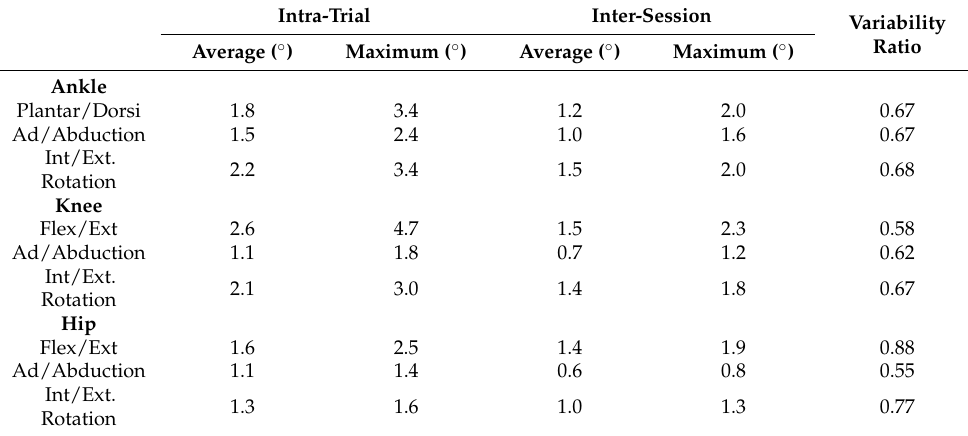
Table 2. Average and maximum variation metrics across entire running cycle within individual trial and between testing sessions. Variability ratio computed as quotient between average inter-session variability divided by average intra-trial